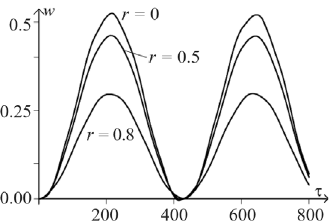
( ) , w r τ ( ) , w r τ . . Figure 6. Temporal and spatial dependencies for deflection w ( r , τ ) .